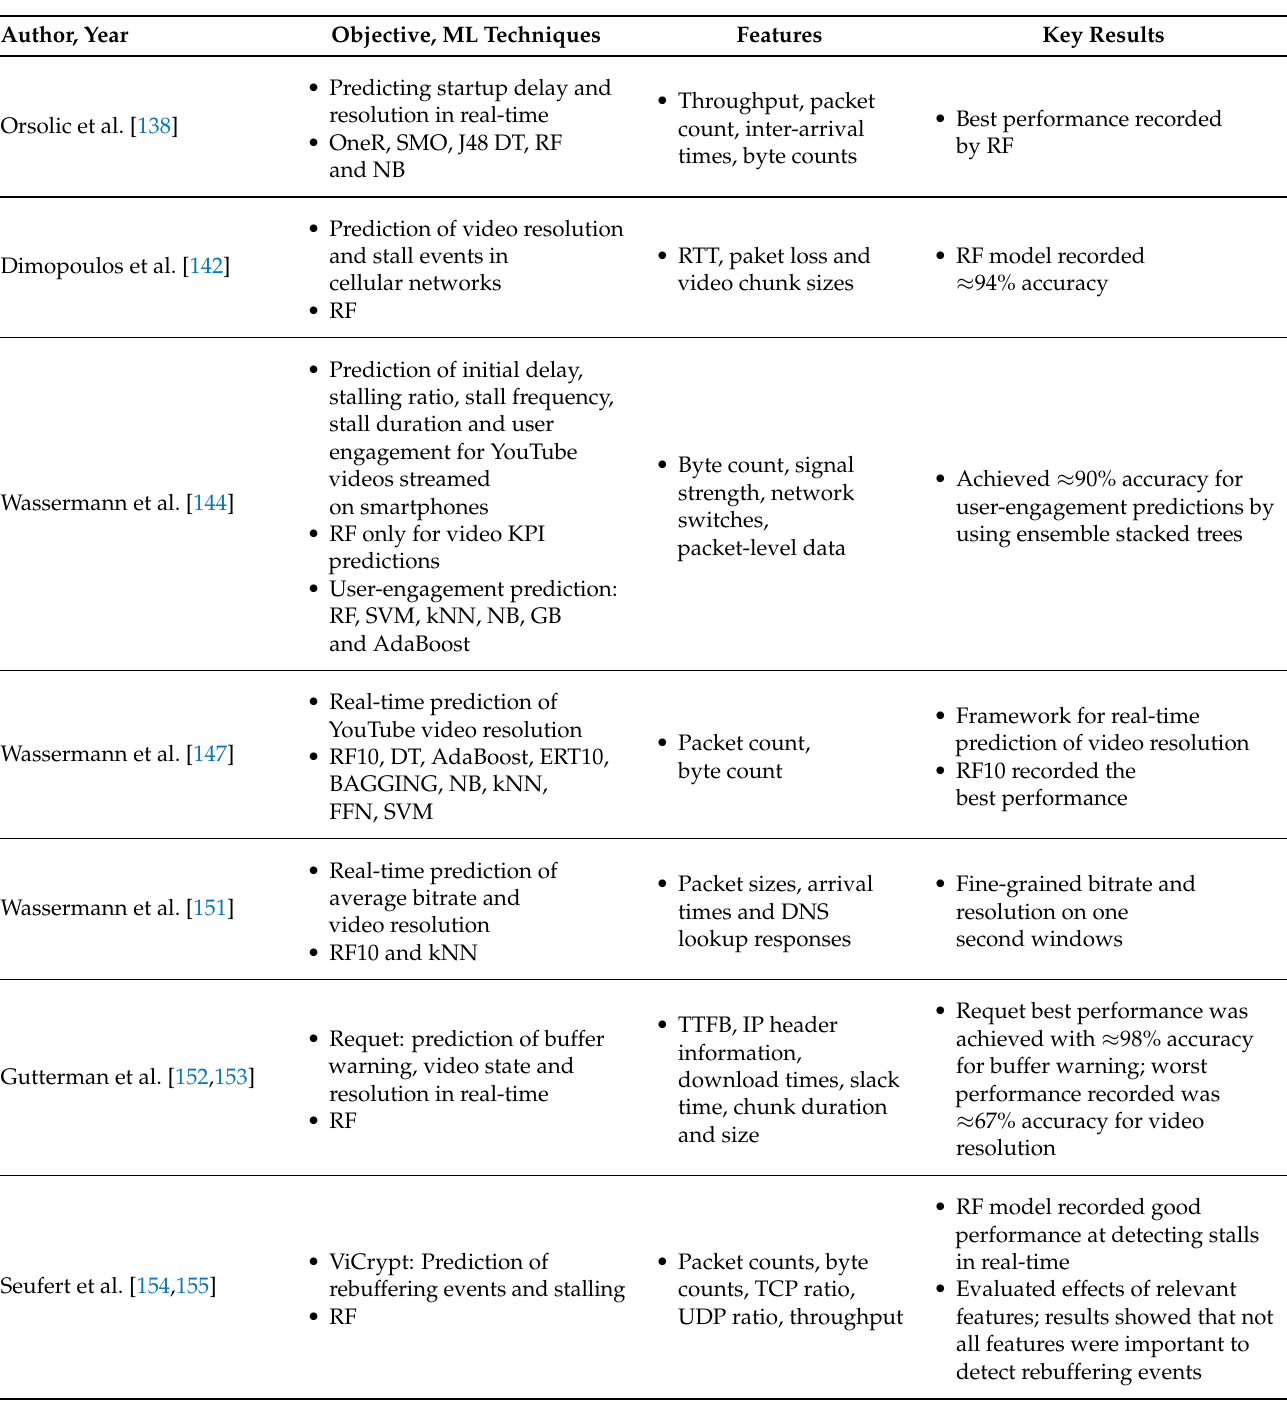
Table 3. Summary of video quality prediction from encrypted